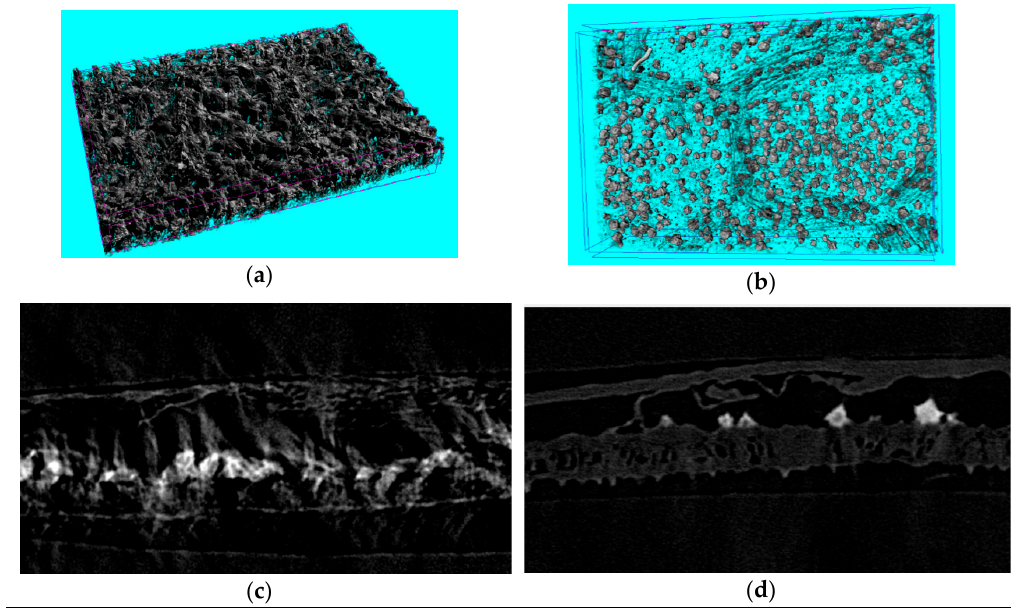
Figure 5. The nano-computed tomography (nano-CT) anatomy of plane fault ( a , b ) and sectional anatomy of Folium nelumbinis ( c , d ) treated by different extracting methods. ( a , c )—Single-phase extraction, ( b , d )—Osmosis extraction.